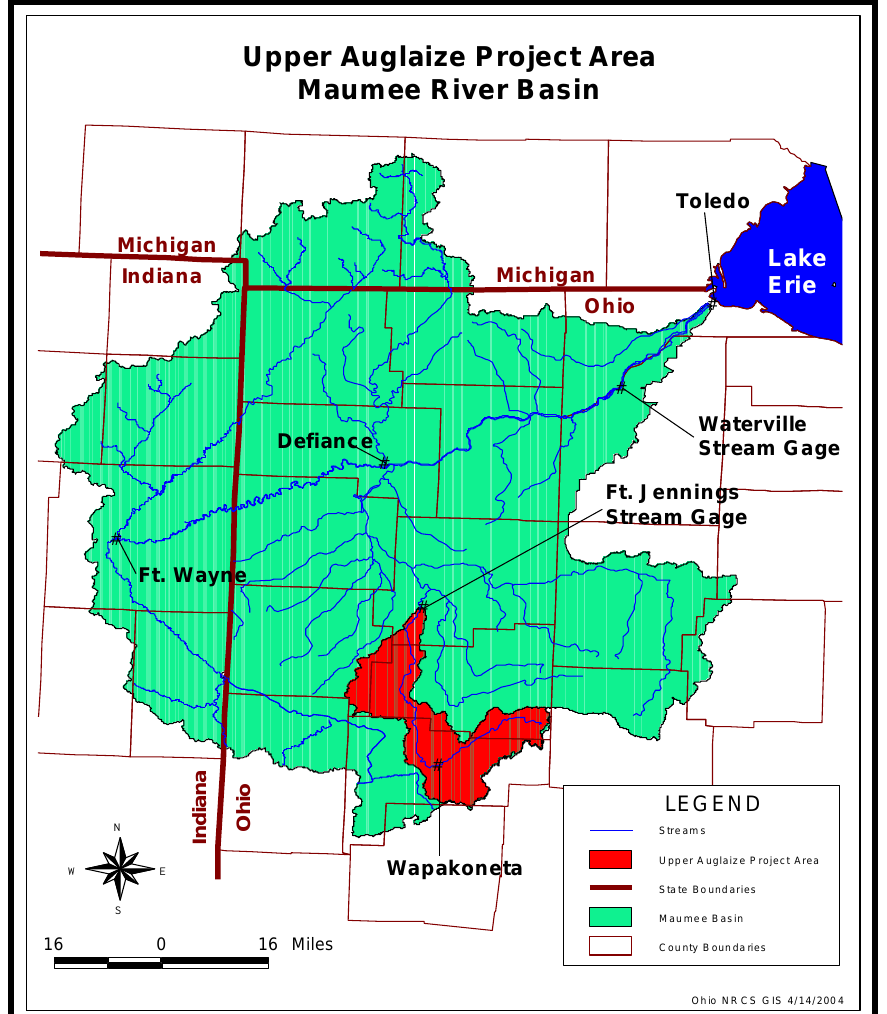
Figure 2 . The Maumee River basin drainage network, Upper Auglaize watershed, and the Wapakoneta and Fort Jennings Gage